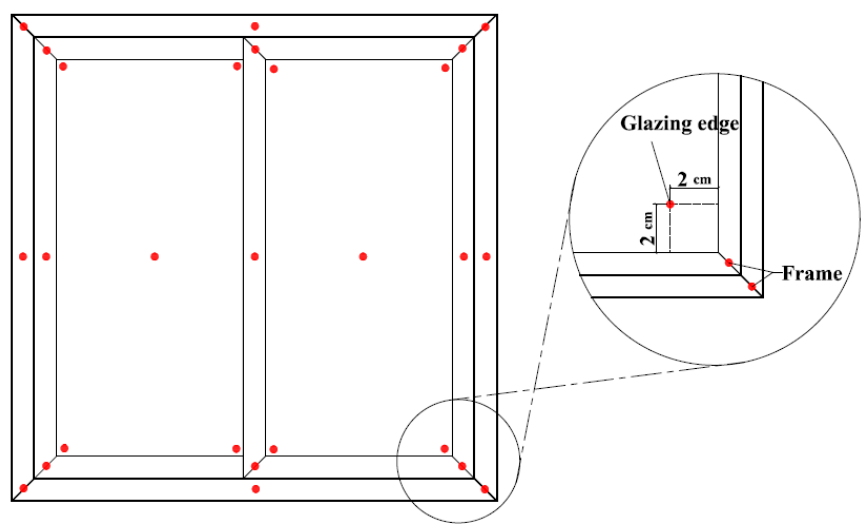
Figure 6. Temperature Difference Ratio evaluation locations specified in the Korean Design Standard for Preventing Condensation in Apartment Buildings [9]. Table 3. Allowed maximum TDR for each region in the Korean Design Standard for Preventing Condensation in Apartment Buildings [9].